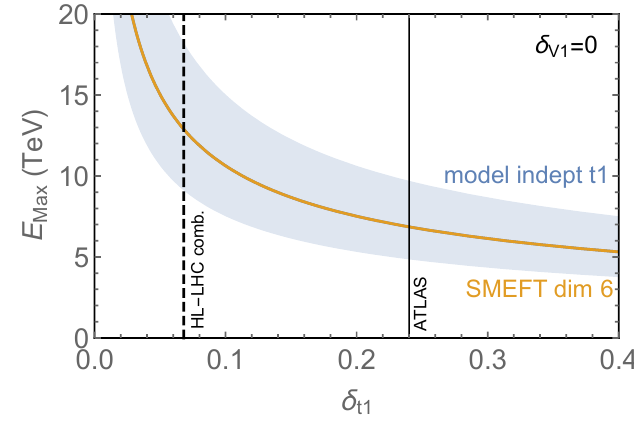
Figure 10 . The unitarity bound on δ t 1 assuming δ W 1 , δ Z 1 = 0 . The model-independent bound is equal to the optimal bound for all values of δ scale results from varying the unitarity bound to 1 95% C.L. limits on the coupling from ATLAS [30] and a projected HL-LHC combination [24].